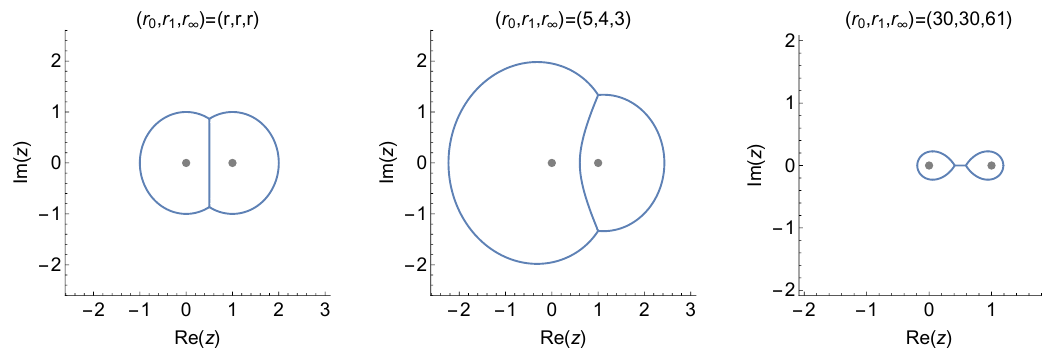
Figure 24 . Horizontal trajectories of the JS di(cid:11)erential of (cid:6) 0 ; 3 in (D.17). Three poles are at z = 0 ; 1 ; 1 , denoted by gray dots. Two zeroes are at z = 1 the middle, and z = 1